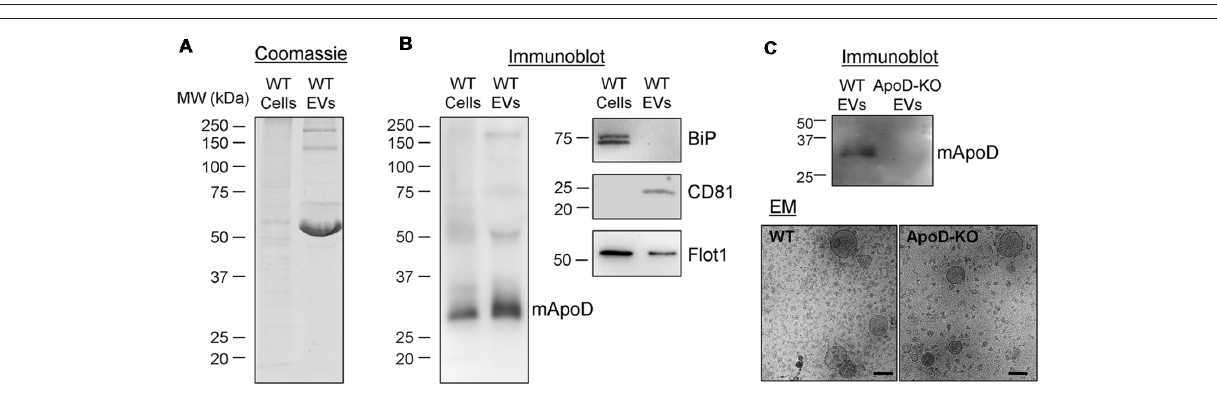
FIGURE 6 | Primary murine astrocytes produce ApoD-positive EVs. (A) Coomassie blue staining of whole cell extracts and EV preparation (240 times concentrated, relative to the starting cell culture) from wild-type (WT) primary astrocytes. (B) Immunoblot analysis of ApoD, the endoplasmic reticulum marker BiP, and the EV markers CD81 and flotillin-1 in cell lysates and EV preparations from WT primary astrocytes. No signal of BiP is detected in the EV preparation. Intracellular CD81 is not detectable in the cell extract. (C) Immunoblot analysis of ApoD in WT and ApoD-knock-out (KO) primary astrocyte EV preparations, confirming the presence of ApoD in WT EVs. Immunoelectron microscopy images of WT and ApoD-KO EVs. Calibration bars: 100 nm.